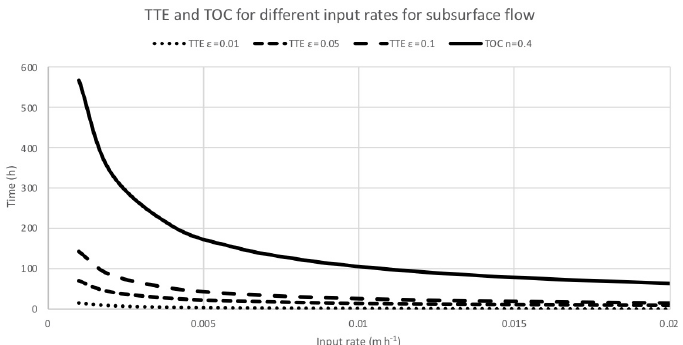
Figure A1. Time of concentration (TOC, solid line) and time to equilibrium (TTE, dashed lines) for subsurface flow on a hillslope of 100m for different input rates and values of effective porosity (TOC is constant for each input rate) ( K o = 2mh − 1 , sin β = 0 . 05) (Eqs. A7 and A8).